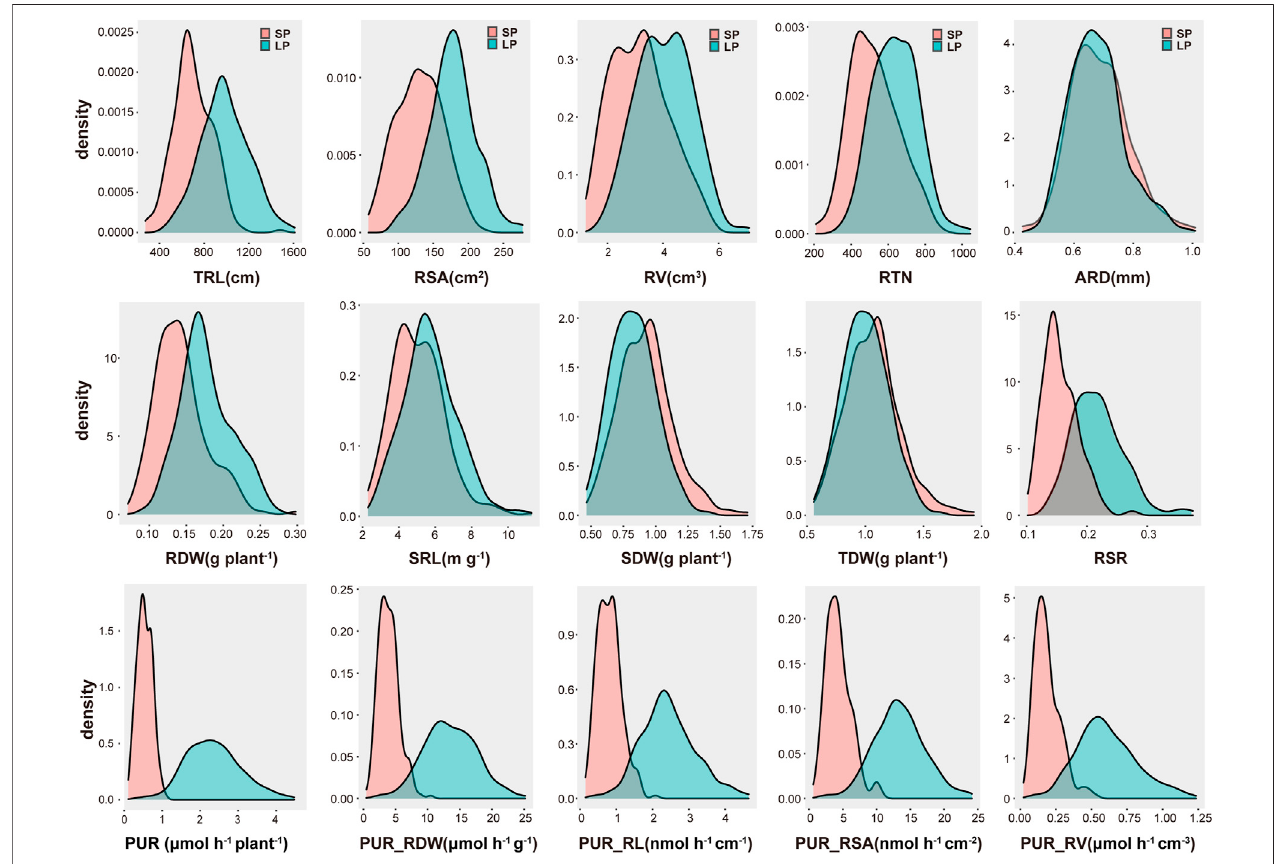
FIGURE 2 | Phenotypic distribution of 12 traits under low-P (LP) and suf fi cient-P (SP) conditions.